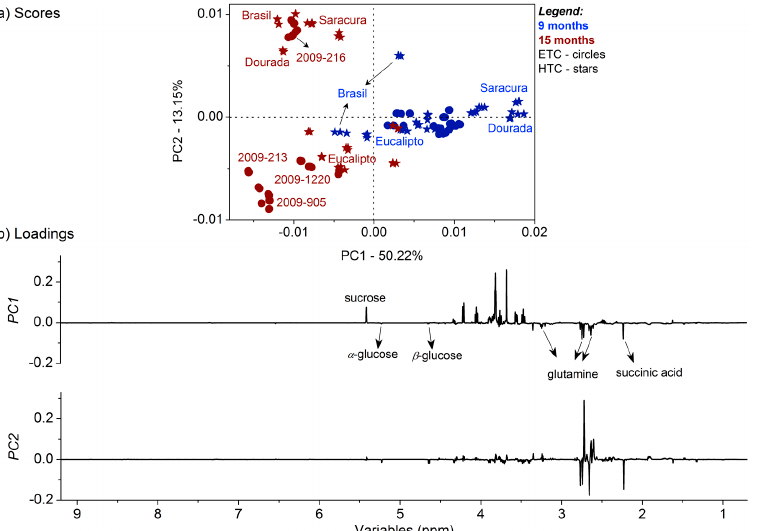
Figure 2. PC1 × PC2 scores coordinate system ( a ) and respective loadings ( b ) of different genotypes of cassava. Legend: cassava genotypes harvested nine months after planting in blue and 15 months after planting in red; HTC genotypes are illustrated as stars and ETC as circles.